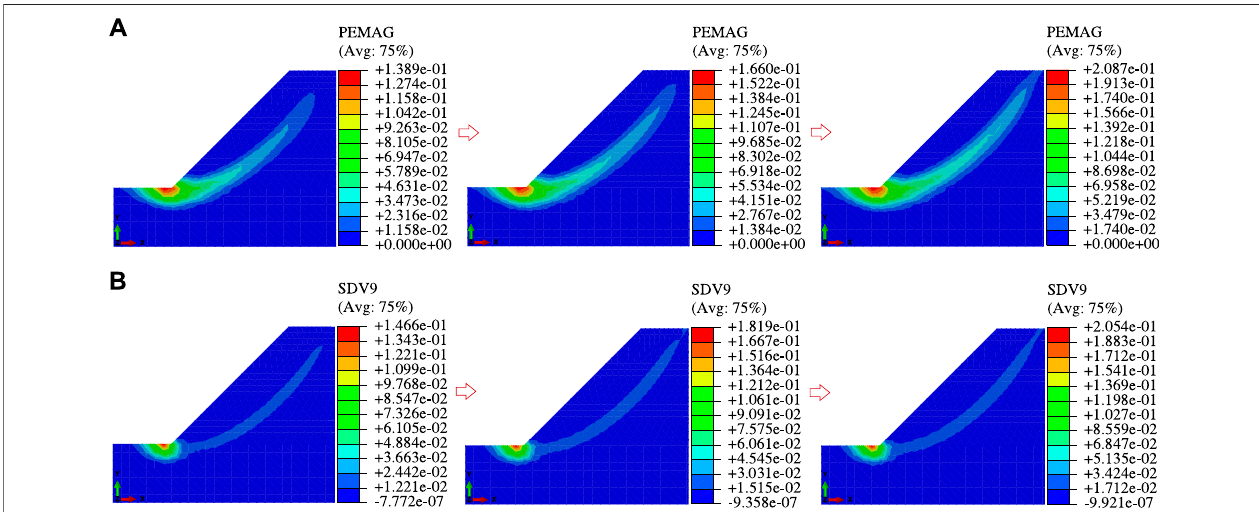
FIGURE 13 | Development of the equivalent plastic strain zone of a progressively unstable slope: (A) M-C yield criterion and (B) tension-shear and compression- shear joint yield criterion.